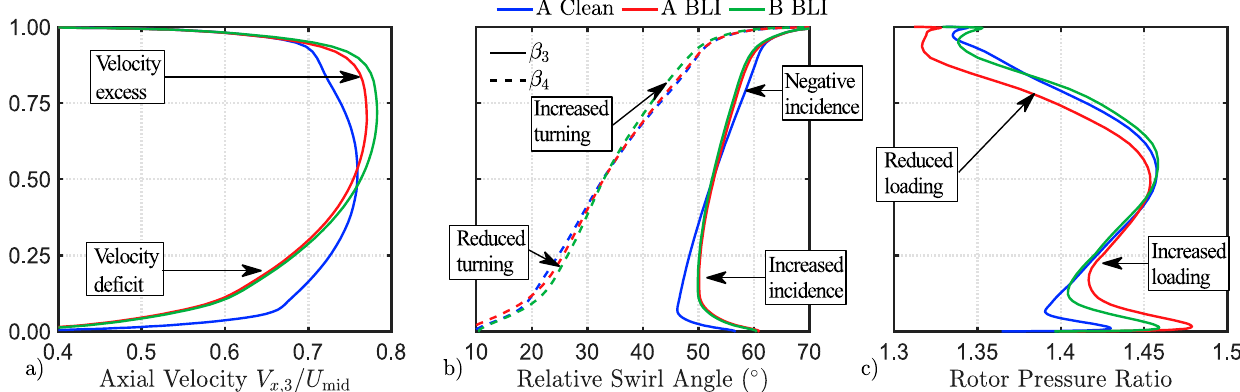
Figure 11. Spanwise distributions at the ADP of: ( a ) axial velocity, ( b ) relative swirl angle, ( c ) rotor pressure ratio.